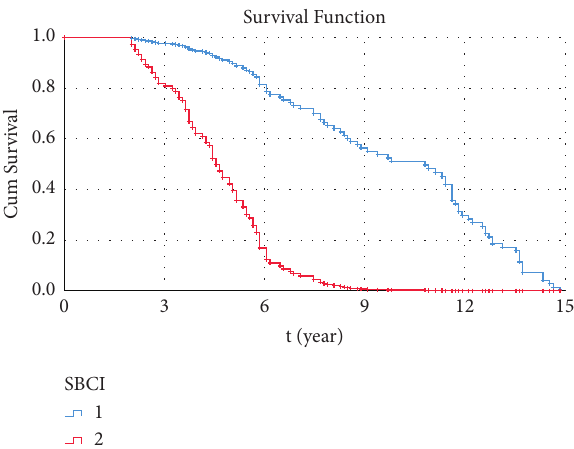
Figure 4: Survival curves for each level of the